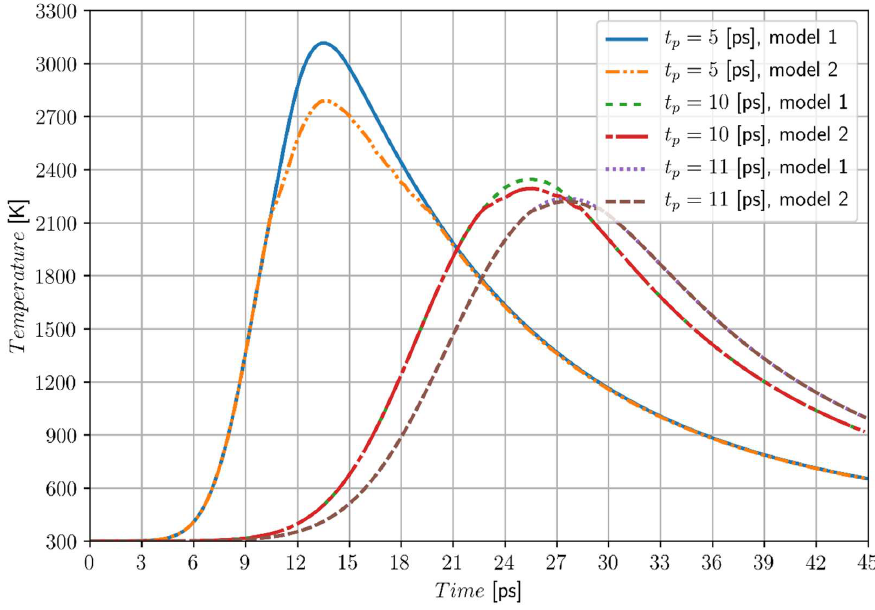
Figure 4. Temperature history at the point P 1 (0, 0), model 1—artificial mushy zone ( ∆ T = 3 K), model 2—melting at the constant temperature, chromium, I 0 = 1.6 × 10 4 J/m 2.